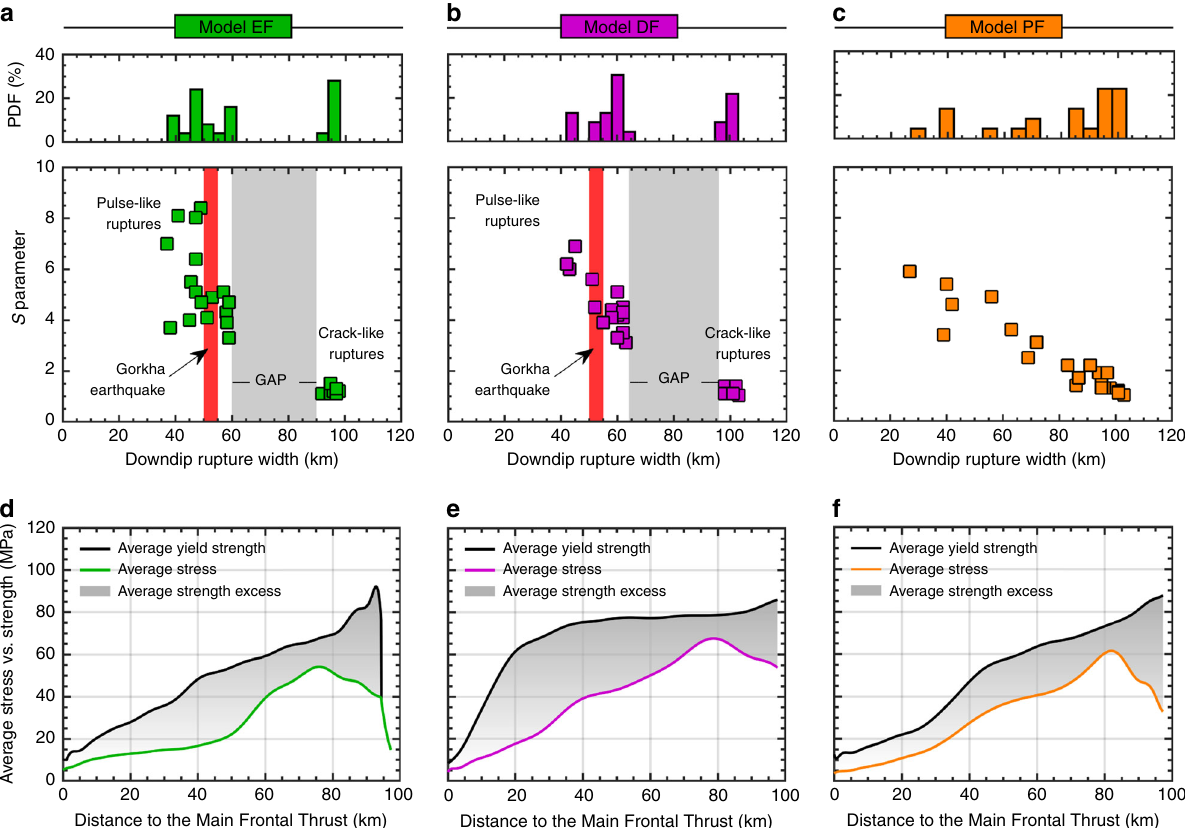
Fig. 4 Impact of the three fault geometries on the rupture patterns. Relationship between the S parameter and rupture width for models adopting a realistic ramp- fl at-ramp fault geometry inferred from Elliott et al. 9 ( a ) and Duputel et al. 10 ( b ), which also indicates the dominance of different rupture styles (pulse- vs. crack-like ruptures), and a planar fault geometry ( c ). d – f , Along megathrust pro fi les of the average stress vs. strength for the three fault geometries adopted: models EF ( d ), DF ( e ) and PF ( f ). Our simulations also indicate that, for each partial rupture, the S parameter is generally higher than in dynamic rupture simulations 45 . This results from the large amount of slip velocity-induced weakening ( γ ; see Methods section), which is motivated by